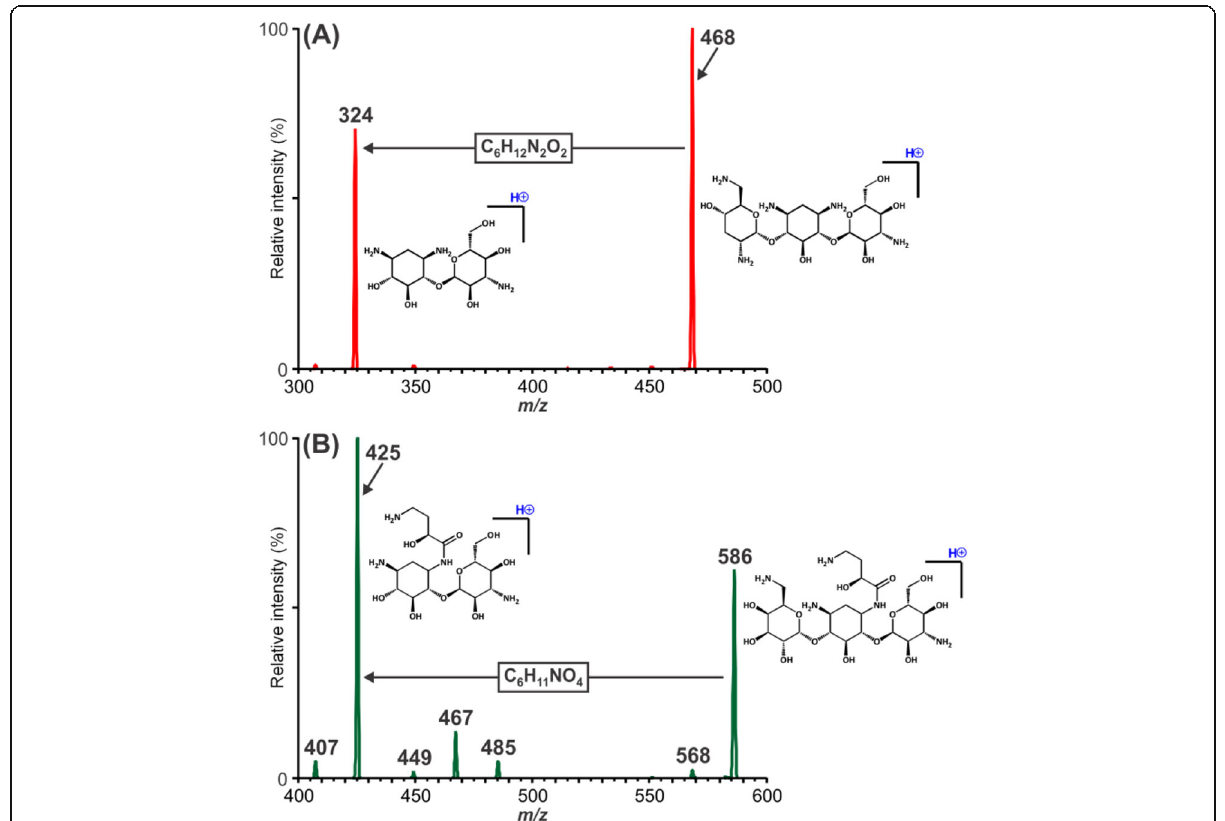
Fig. 4 Product-ion spectra acquired from m/z 468 ( a ) and m/z 586 ( b ) ions from tobramycin and amikacin,